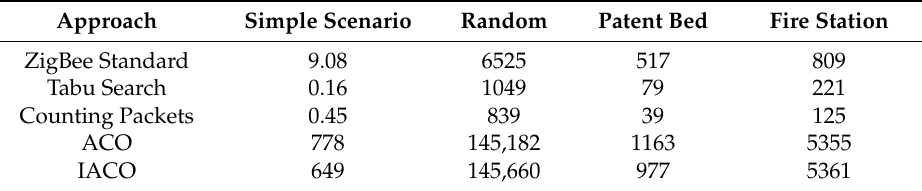
Table 23. Packets Dropped Comparison.